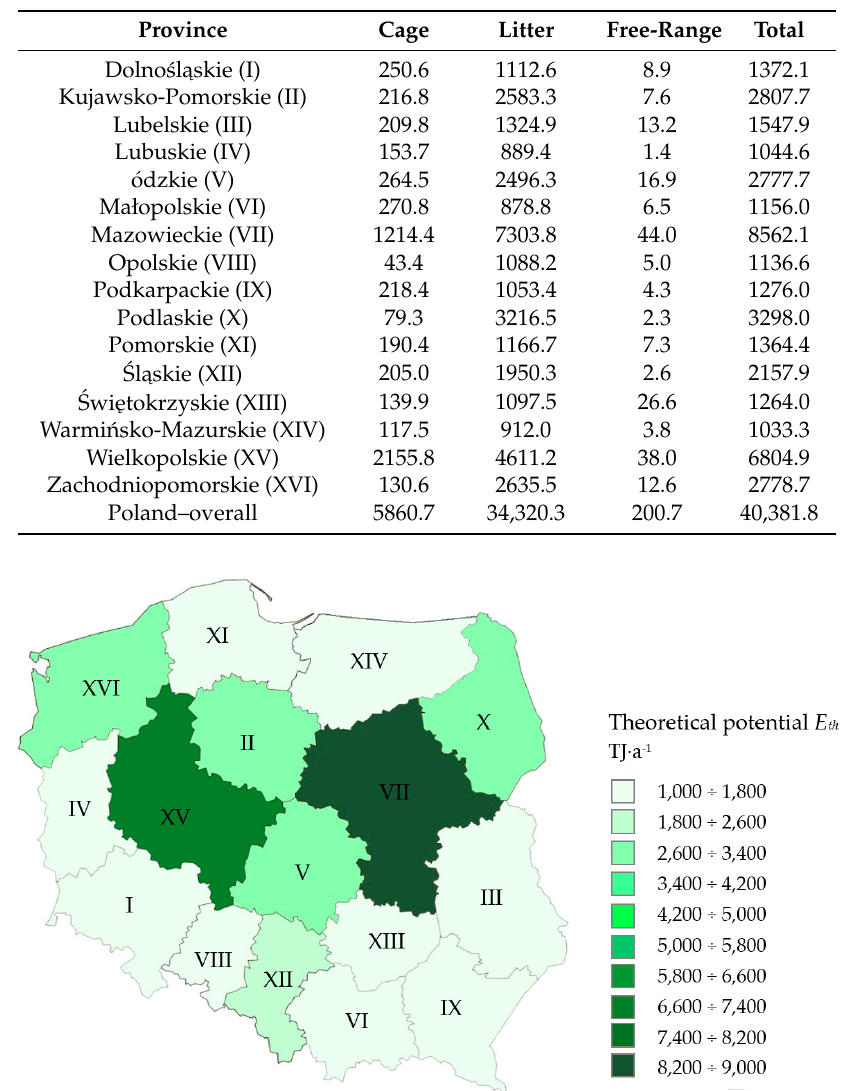
Figure 5. Energy potential of chicken manure in provinces in Poland derived on the theoretical level.